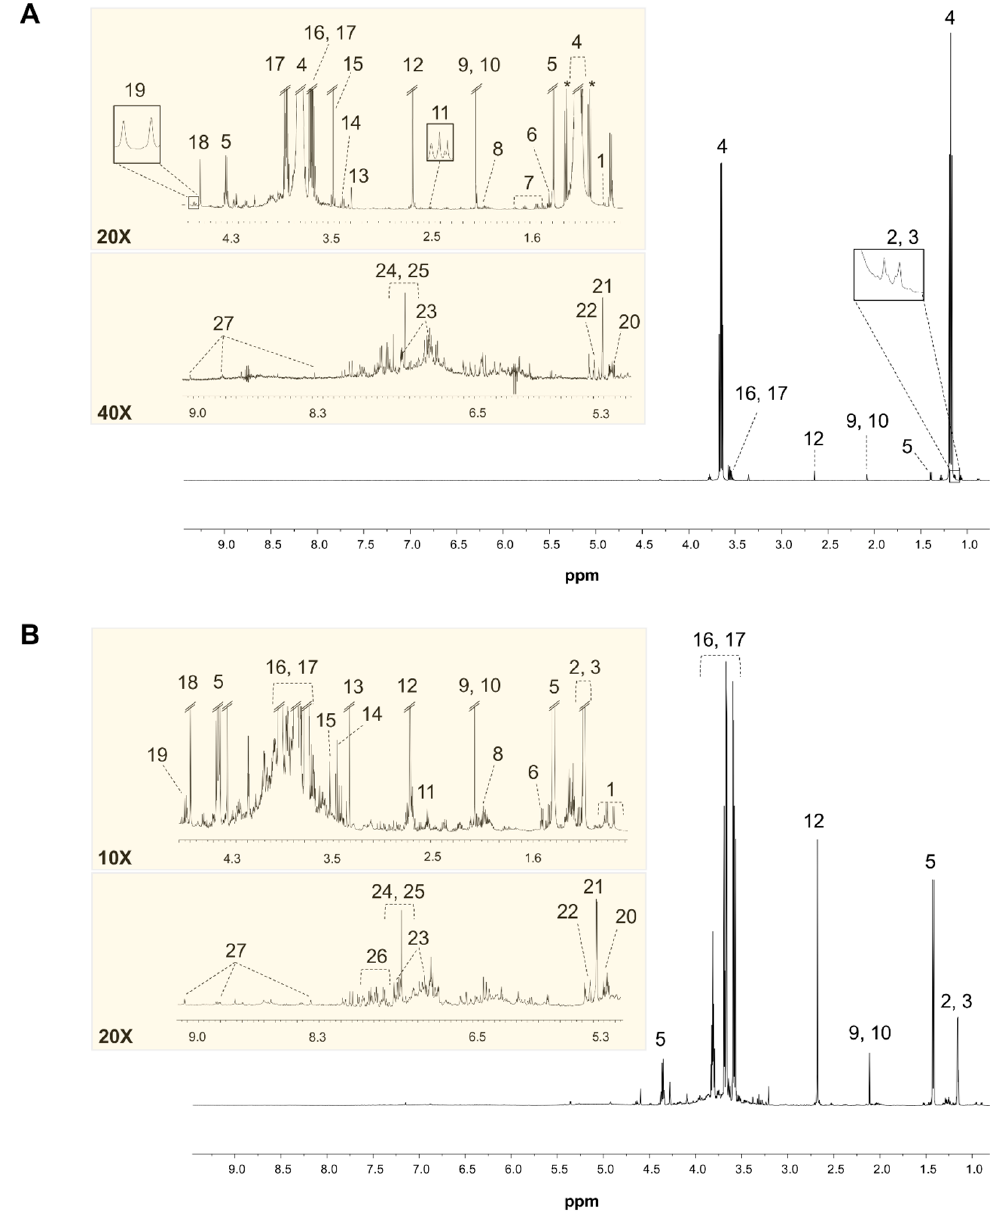
Figure 1. Representative 1 H-NMR spectra of wet ( A ) and dried wine ( B ) samples. The major resonances have been assigned: 1. Valine; 2. 2,3-butanediol; 3. Isopropanol; 4. Ethanol; 5. Lactic acid; 6.